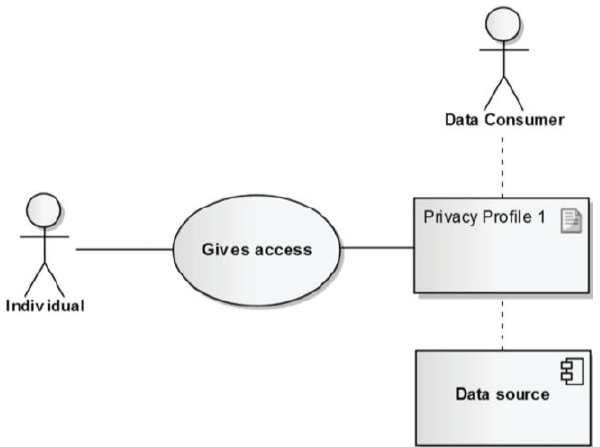
Figure 2. Access to a public data source granted by an